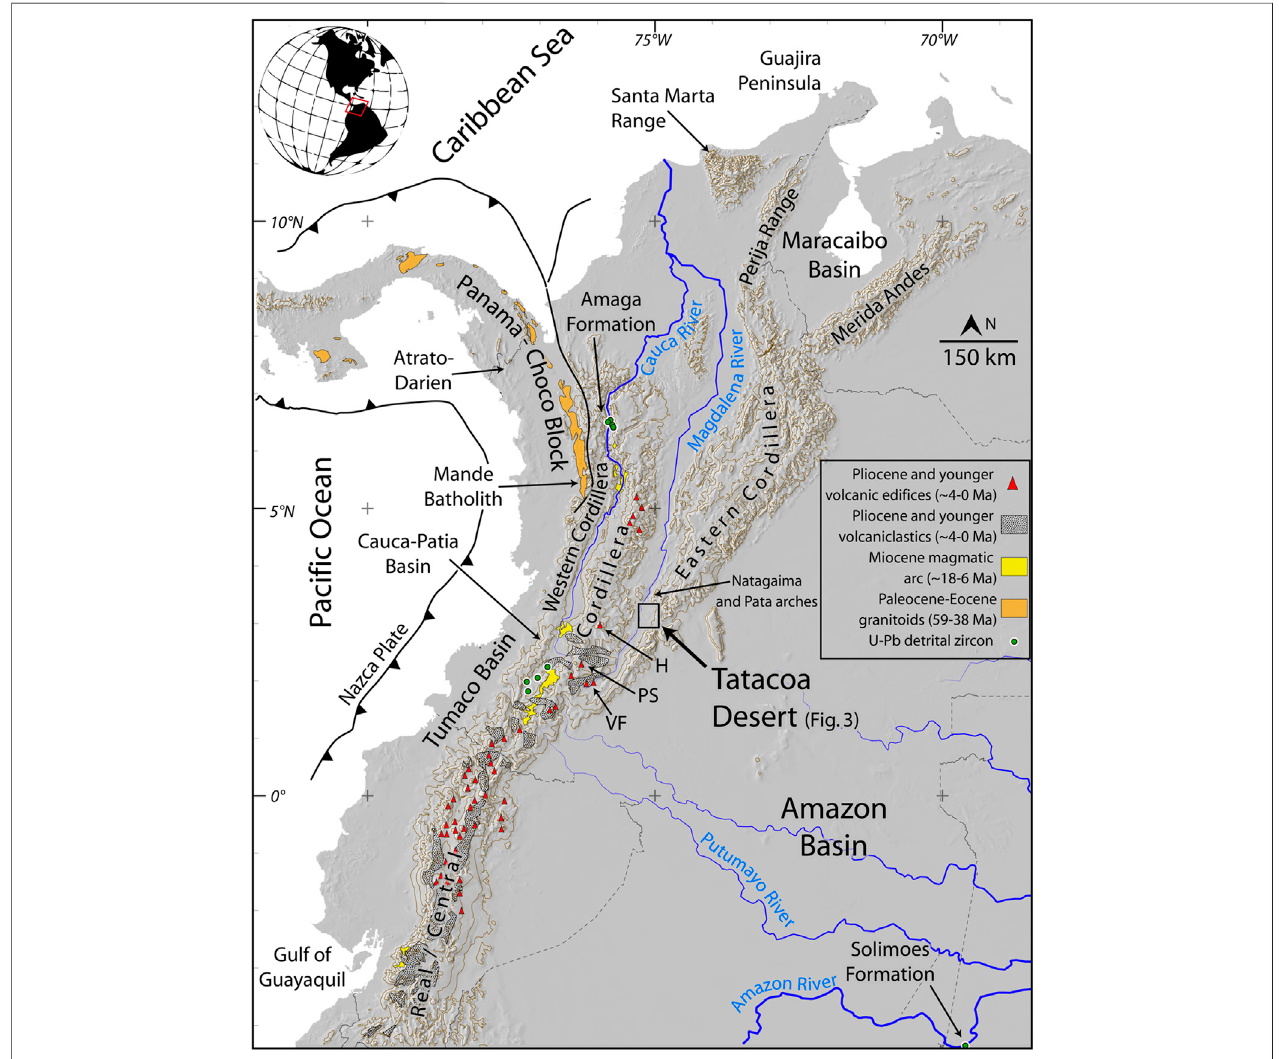
FIGURE1 | General location map ofthe Northern Andes (the Andean block ofPennington, 1981),contourlines every 1,000 m. Green dotsrepresentU-Pb detrital zircon samples: middle Miocene strata of the Amaga Formation (Montes et al., 2015), the Cauca-Patia Basin (Echeverri et al., 2015), and the Amazon Basin (Kern et al., 2020). The Miocene magmatic arc consists of hypabyssal porphyritic granitoids, while the Panama-Choco Eocene arc consists mostly of granitoids (Leal-Mejia, 2011; Montes et al., 2012; Bineli-Betsi et al., 2017; Leal-Mejia et al., 2019). Pliocene ( ∼ 4 Ma) and younger ignimbrites and volcanoclastic rocks (Barberi et al., 1988; Torres-Hernandez, 2010; Egüez et al., 2017) represent the initial magmatic pulses in the construction of large composite active today in the Northern Andes (H: Huila Volcano, PS: Purace-Sotara volcanoes, VF: Villalobos-La Fragua volcanic center).